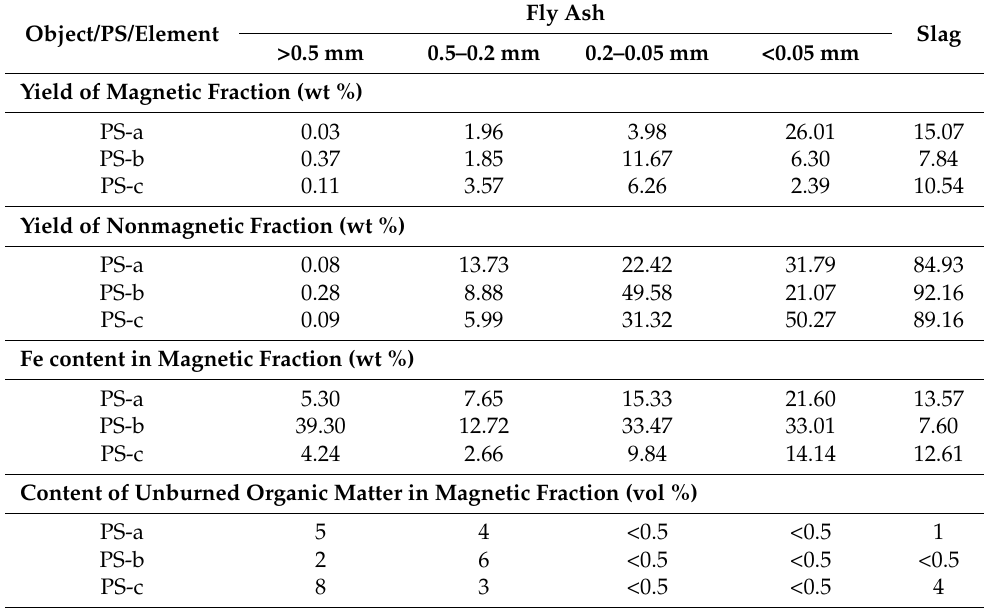
Table 4. Yield fractions, Fe and unburned organic matter content in magnetic fraction, and element contents in whole not full burned organic matter from magnetic fraction of the fly ash and slag from power stations PS-a, PS-b, and